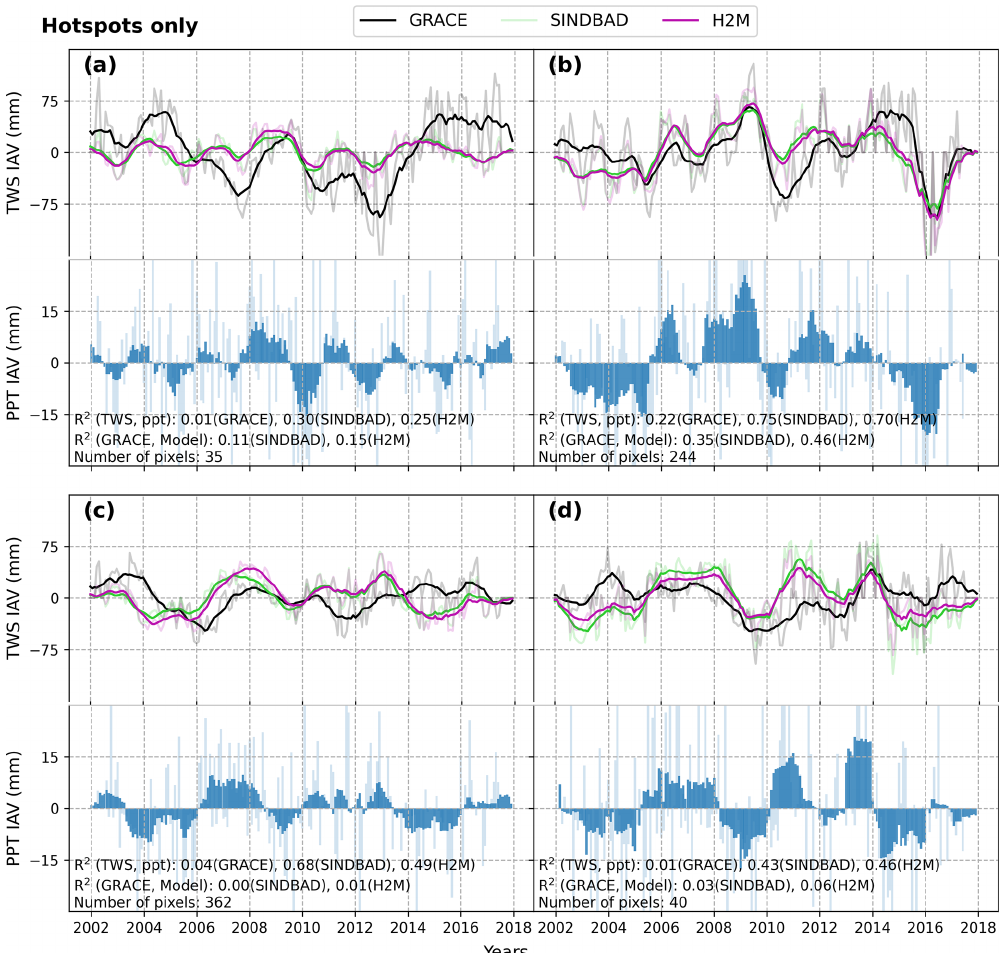
Figure 6. Time series of 12-month moving averages of GRACE and modeled terrestrial water storage (TWS) interannual variability (IAV) in error hotspots that are commonly identified by SINDBAD and H2M (Fig. B7) within each selected region. The Laurentian Great Lakes ( a ; region 5), the Amazon ( b ; region 7), eastern and western Africa ( c ; regions 15 and 16), and South Asia ( d ; region 23) are shown. SREX regions are shown in Fig. B2. Monthly values are shown with faded